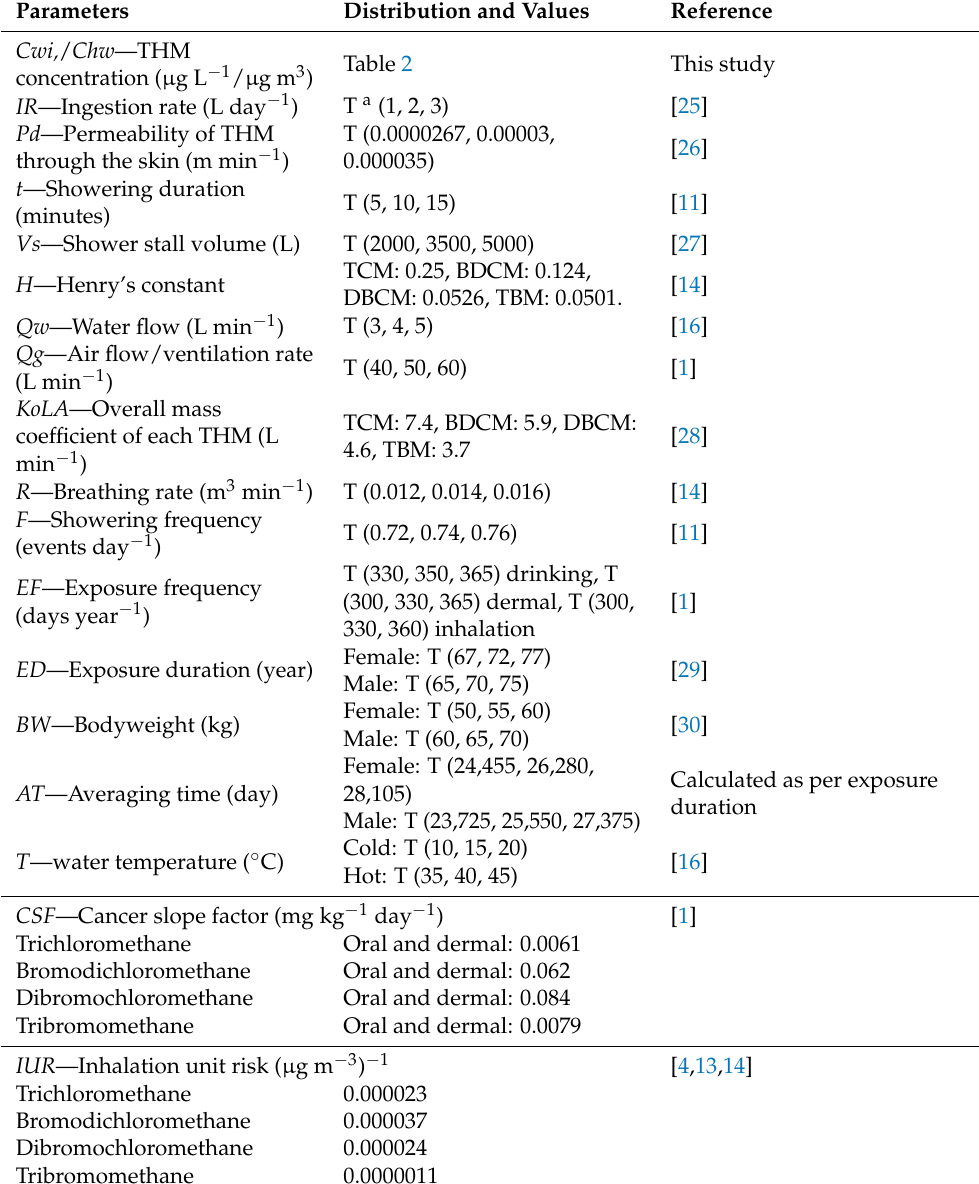
Table 1. Model input parameters and their